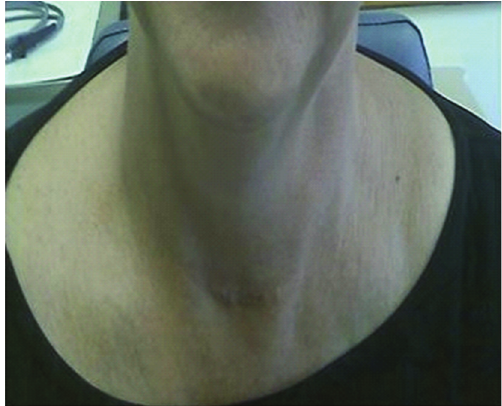
Figure 2: Excellent wound healing one week